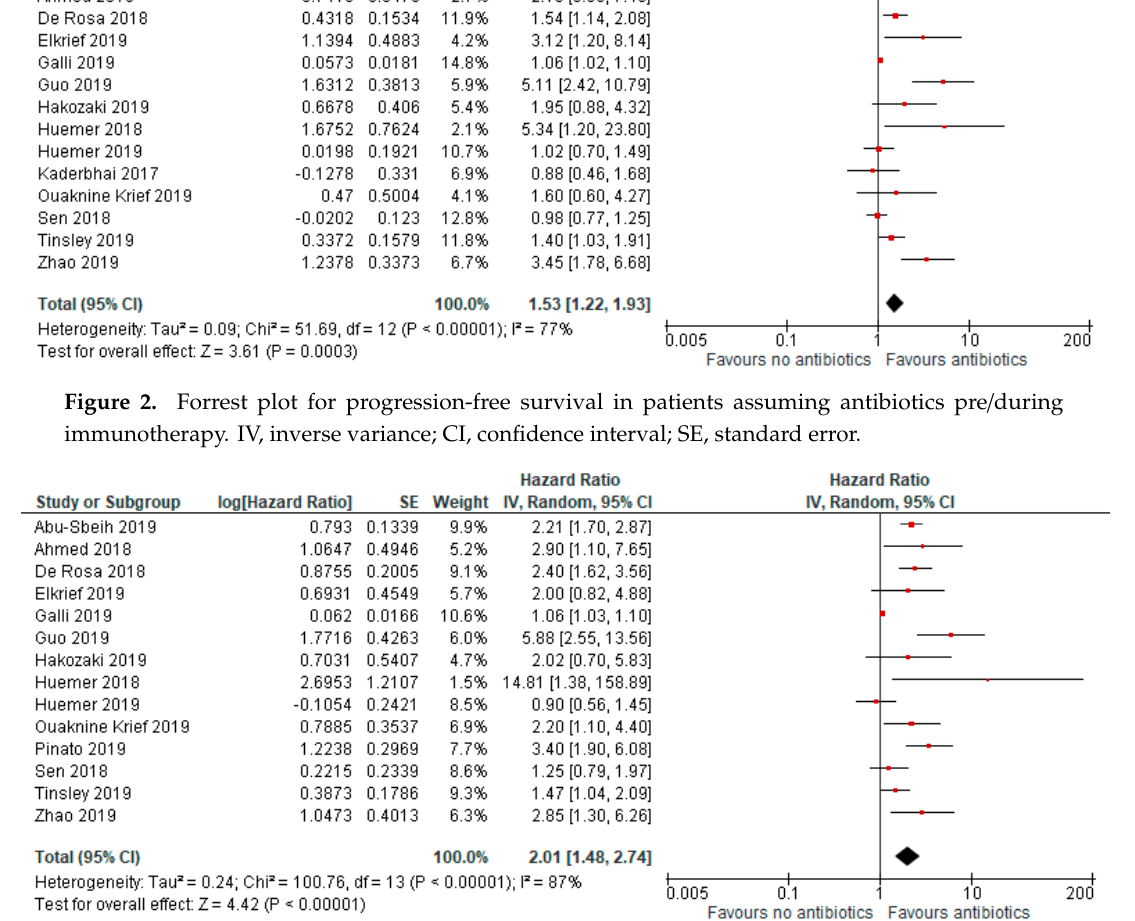
Figure 3. Forrest plot for overall survival in patients assuming antibiotics pre/during immunotherapy.